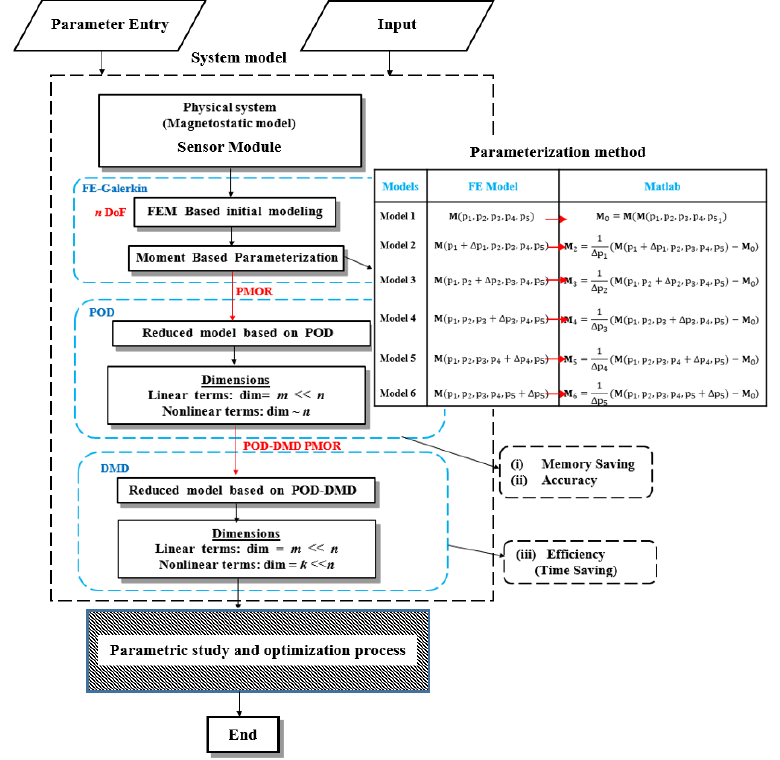
Figure 6. Flowchart for System Design and Analysis.